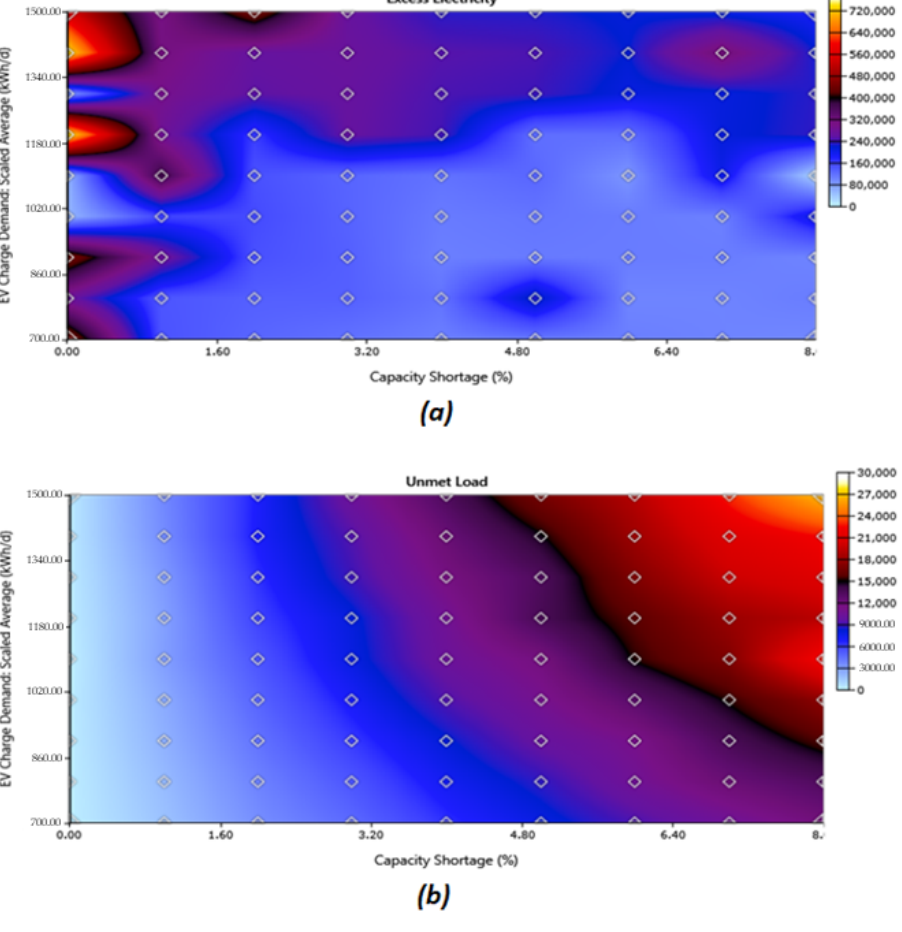
Figure 18. Impact of the sensitivity parameters on ( a ) the excess energy, and ( b ) the unmet electric load of the optimal charging station.